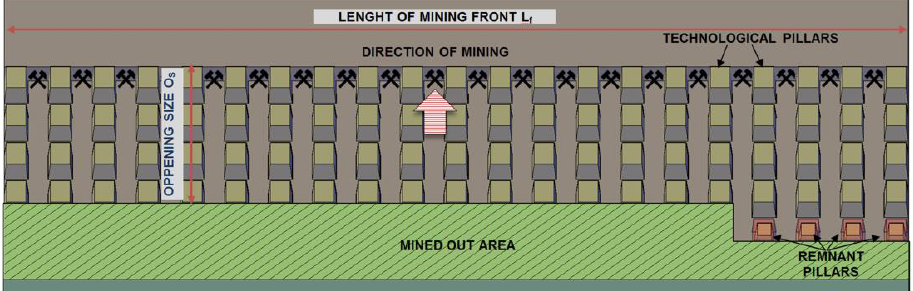
Figure 9. One-phase room-and-pillar mining system with roof deflection.